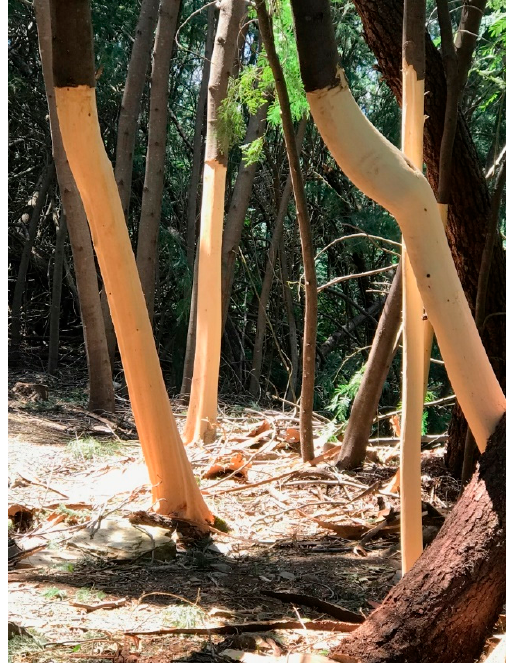
Figure 10. Peeling of Acacia dealbata . The peeling technique should cause all the bark to be peeled from approximately 1.30m to the